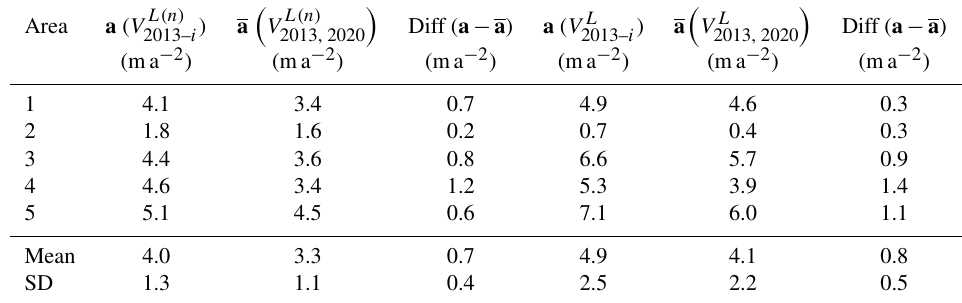
Table A2. Acceleration estimates using least squares regression a and simple average a applied to L velocities of 7 years V L(n) and 1 year V L .